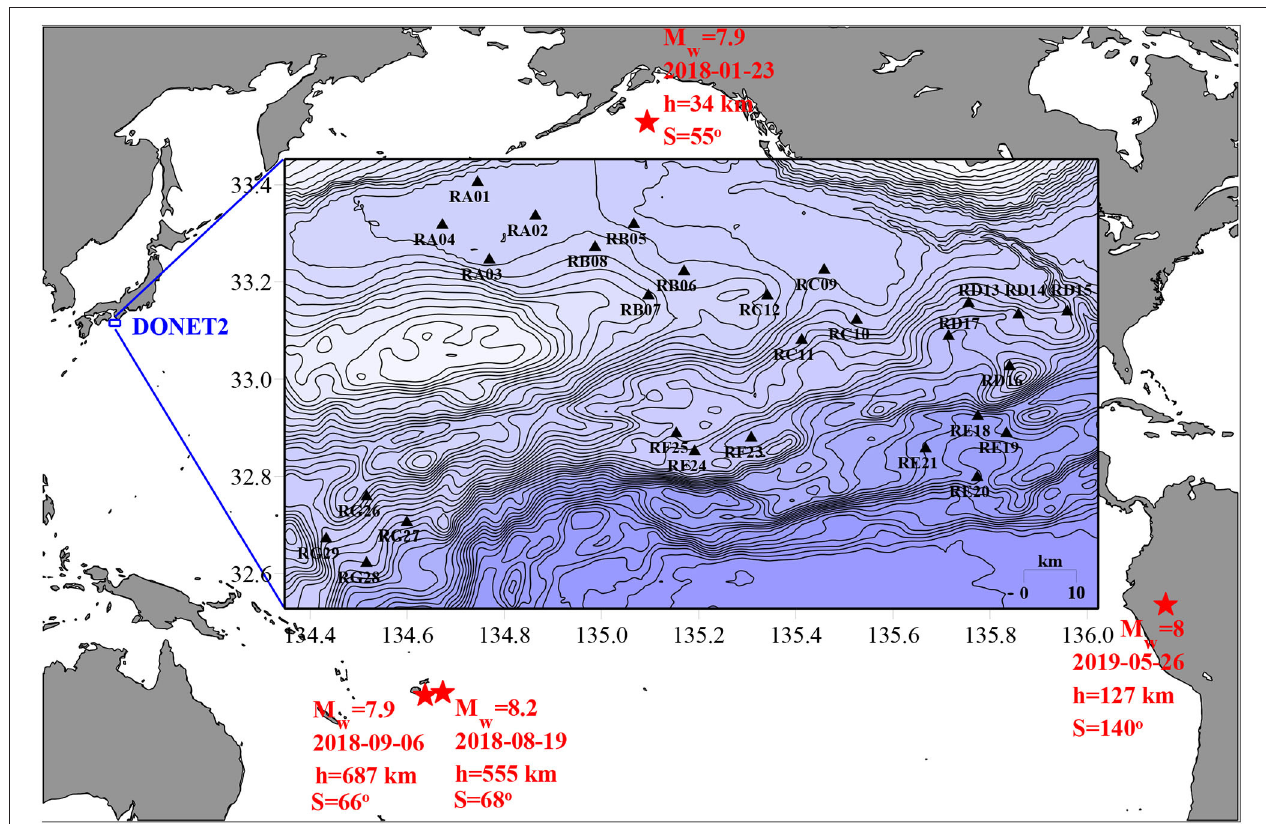
FIGURE 1 | Mutual arrangement of the DONET-2 system and the epicenters of four earthquakes, the signals of which are analyzed in this work. The following quantities associated with each seismic event are indicated in the figure: the moment magnitude M w , the date, the epicenter depth h and the epicentral distance in degrees of the great circle, S . The insert presents a map with the arrangement of 28 seafloor observatories of the DONET-2 system. The distribution of depths in the insert is shown by isobaths in steps of 100 m. The scale (10 km) is indicated in the lower right angle of the